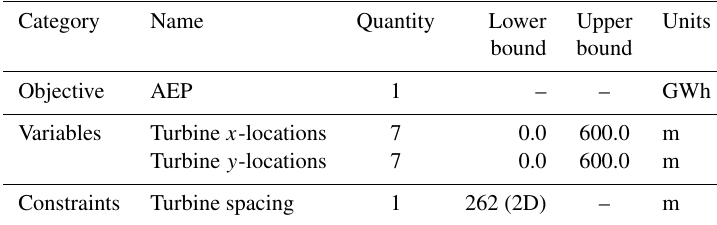
Figure 10. The optimal layout found by the high-fidelity-only optimization (82.368GWh AEP) (a) and the multifidelity method (81.972GWh AEP) (b) . Table 5. Optimization problem formulation for the wind power plant layout AEP maximization case.